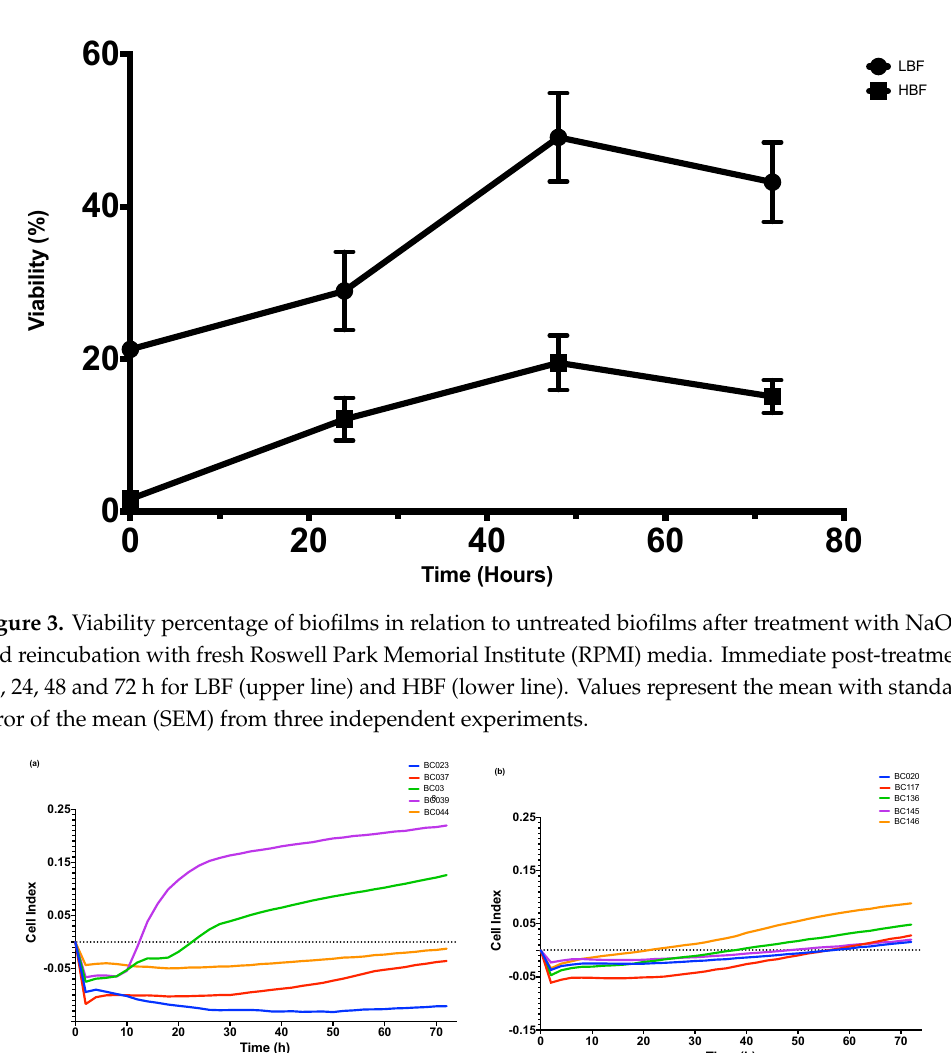
Figure 4. Regrowth from 0 to 72 h as detected by xCELLigence system and presented as normalized cell index for ( a ) five LBF ( b ) five